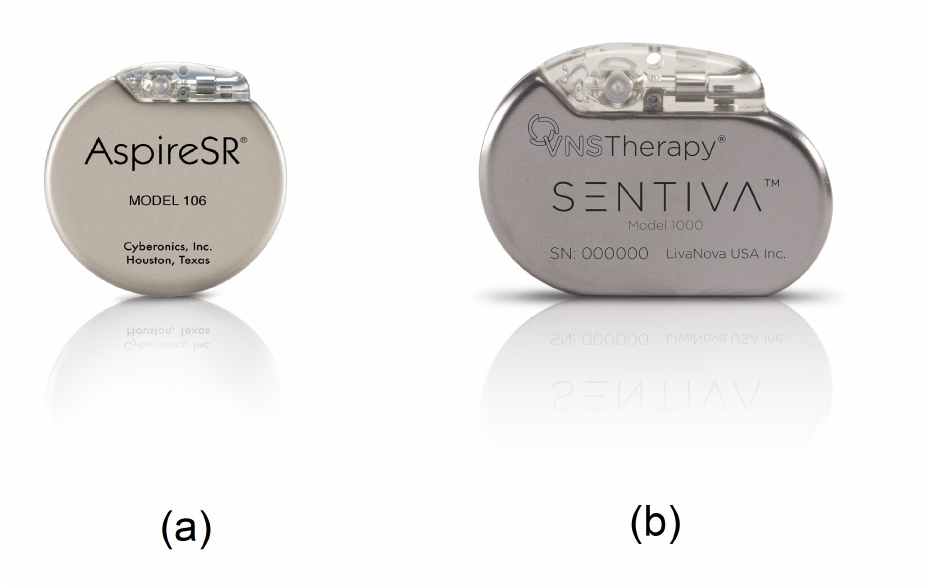
Figure 8. Vagus Nerve Stimulation (VNS) devices by LivaNova [47] including ( a ) AspireSR and ( b ) SenTiva, (Reprinted with permission; copyrighted material of